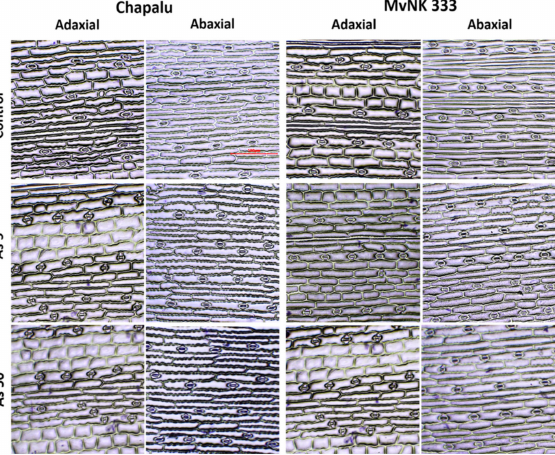
Figure 5. Light microscope images of stomata of maize (cvs. Chapalu and MvNK 333) treated with distilled water (control) and arsenic (As addition: 5 and 50 mg kg − 1 of soil). Scale bar = 100 µ m.